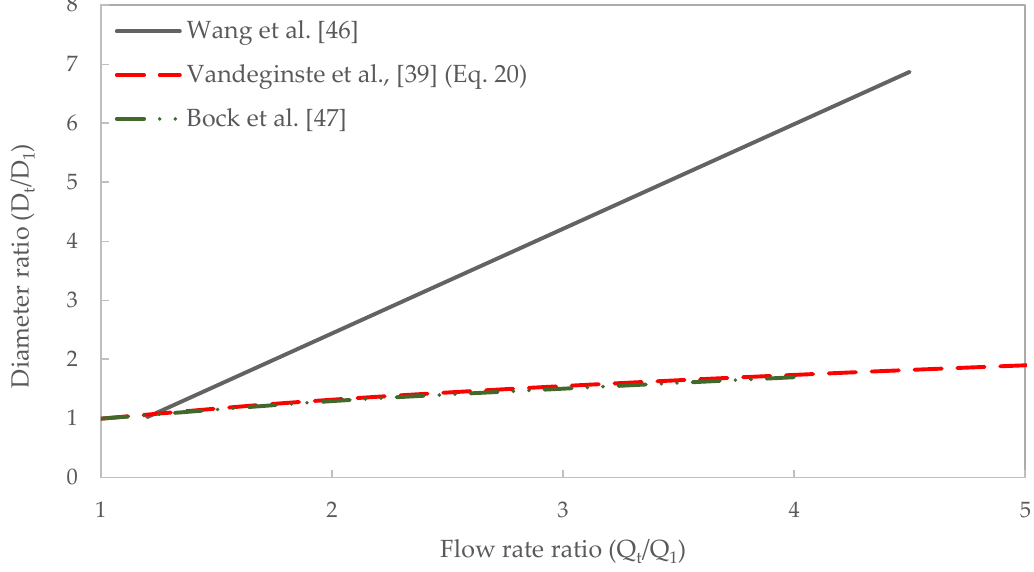
Figure 1. The relationship between diameter ratio and flow rate ratio [39,46,47].